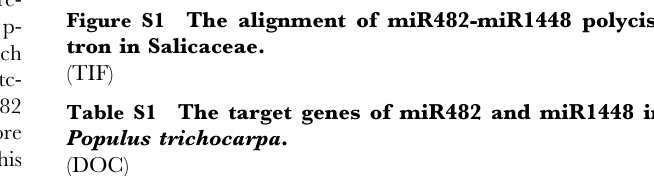
sequencing of miR482-miR1448 polycistrons and